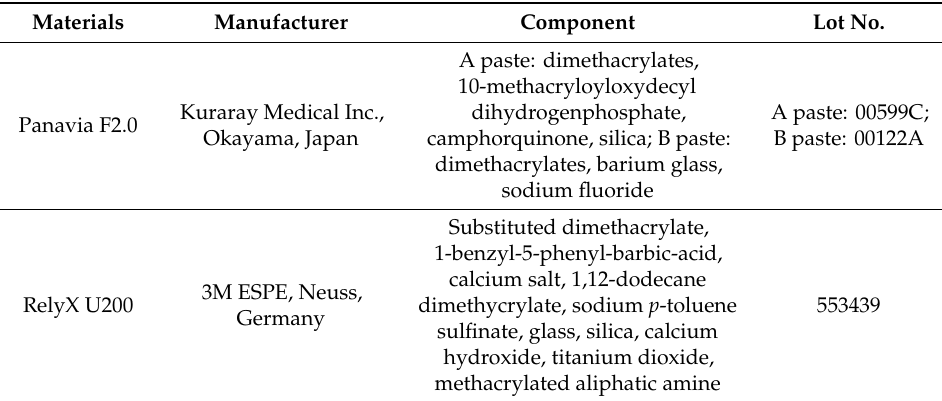
Table 1. Two resin cements